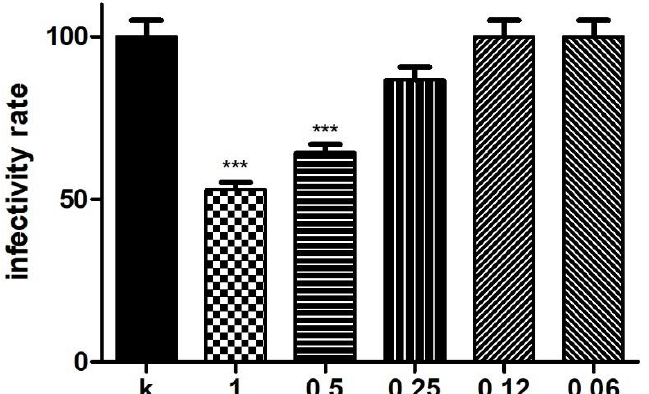
Figure 1. Anti-chlamydial effect of BS derived from L. crispatus BC1. Experiments were performed with different concentrations of BS diluted in PBS (final concentrations ranging from 1 to 0.06 mg/mL) added to 5 × 10 3 EBs at 60-min time point. Chlamydial infectivity was evaluated as IFU/field and expressed as % of control (K) (5 × 10 3 EBs incubated in PBS), taken as 100%. Bars represent mean values, error bars represent SEM. *** p < 0.0001.